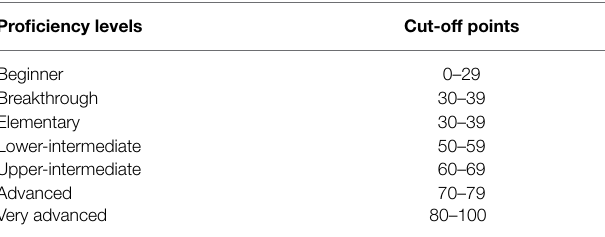
TABLE 1 | Scoring criteria of proficiency levels. Proficiency levels Cut-off